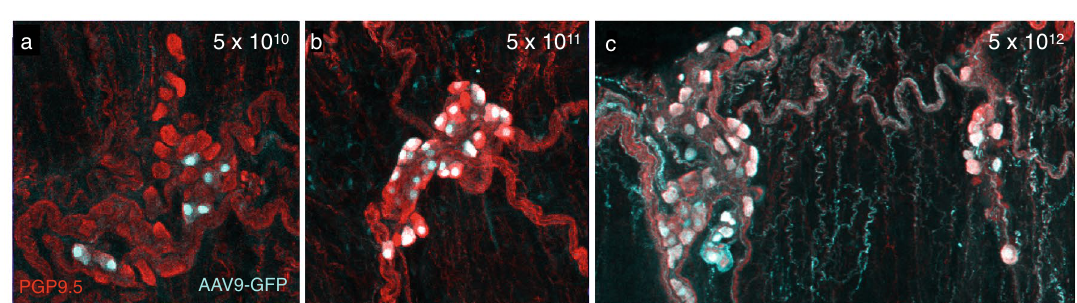
Figure 2. Parasympathetic nerve heterogeneity in mouse airways. Subpopulations of airway nerves express neuronal nitric oxide synthase (nNOS) ( a ), tyrosine hydroxylase (TH) ( b ), and substance P (SP) ( c ). ( d ) Quantification in WT mice: SP n = 24, nNOS n = 10, TH n = 10.